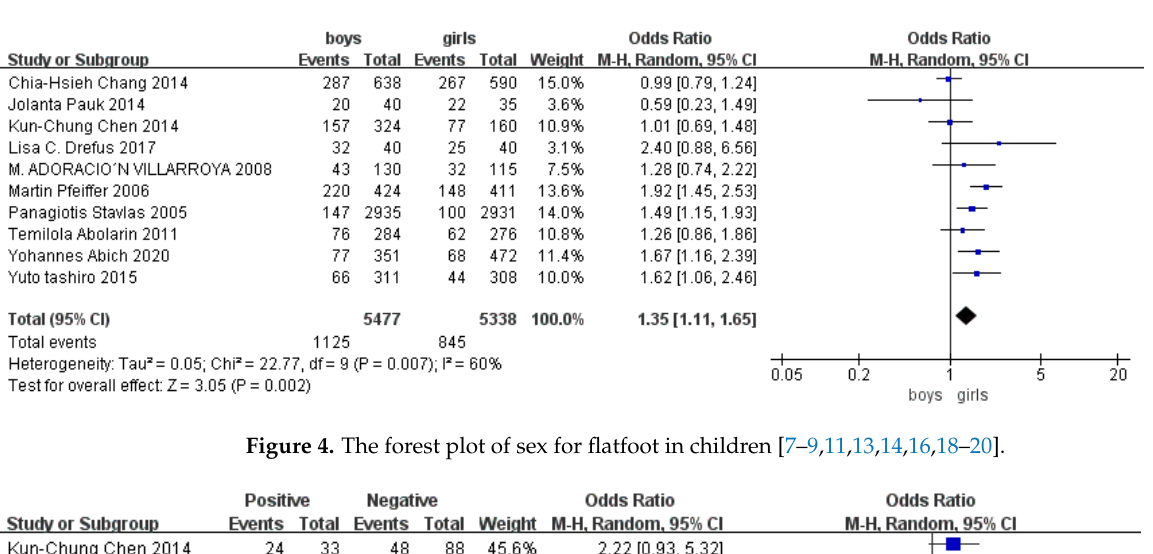
Figure 3. The forest plot of age 6–9 years for flatfoot in children [7,11,13,17].